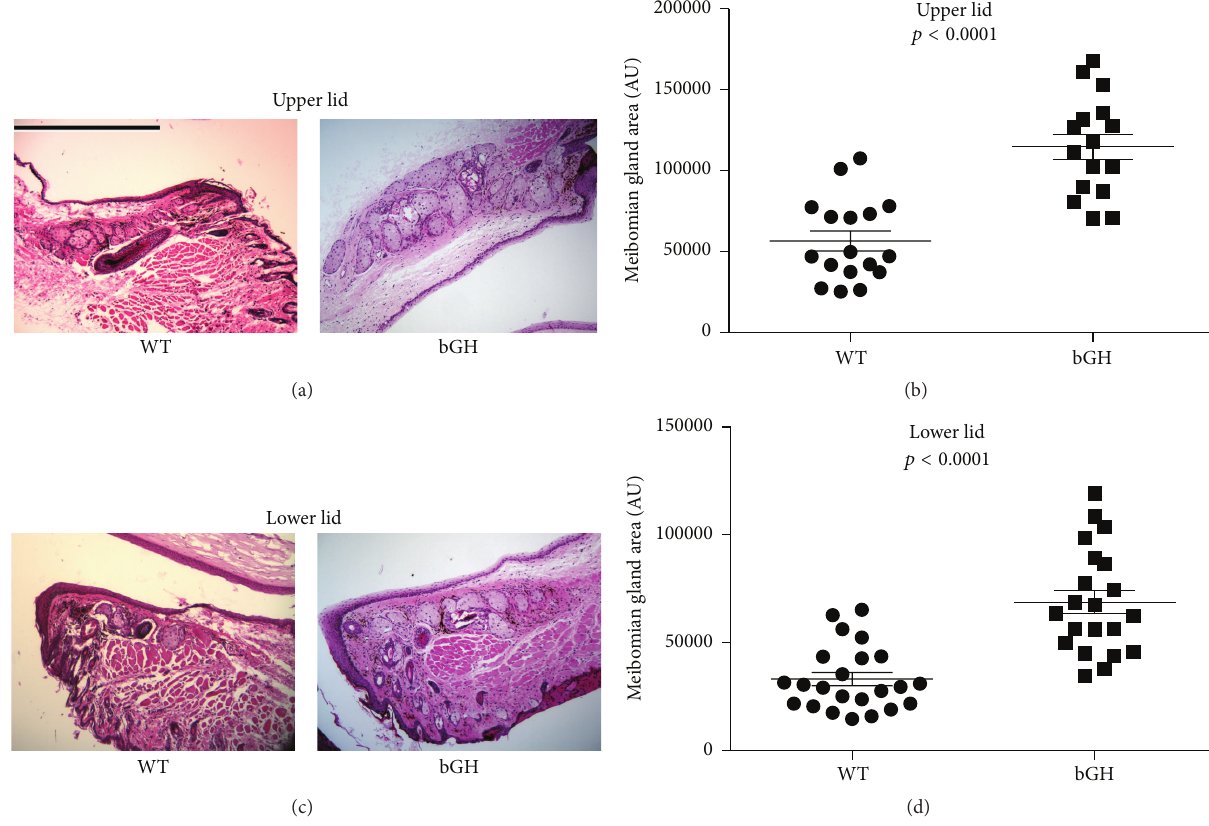
Figure 2: Meibomian gland morphology and size (i.e., area measurement) in male bGH and WT control mice. (a) and (c) H & E staining in the upper and lower lid tissue showing meibomian glands. (b) and (d) quantification of upper and lower lid meibomian gland size. Each data point represents the size of one meibomian gland, the horizontal bar represents the mean, and the error bar represents standard error of the mean (SEM). Data were pooled from 𝑁 = 5 mice in each group. The magnifications for all photographs are 100x, and the size bar in (a) is 500 𝜇 m in